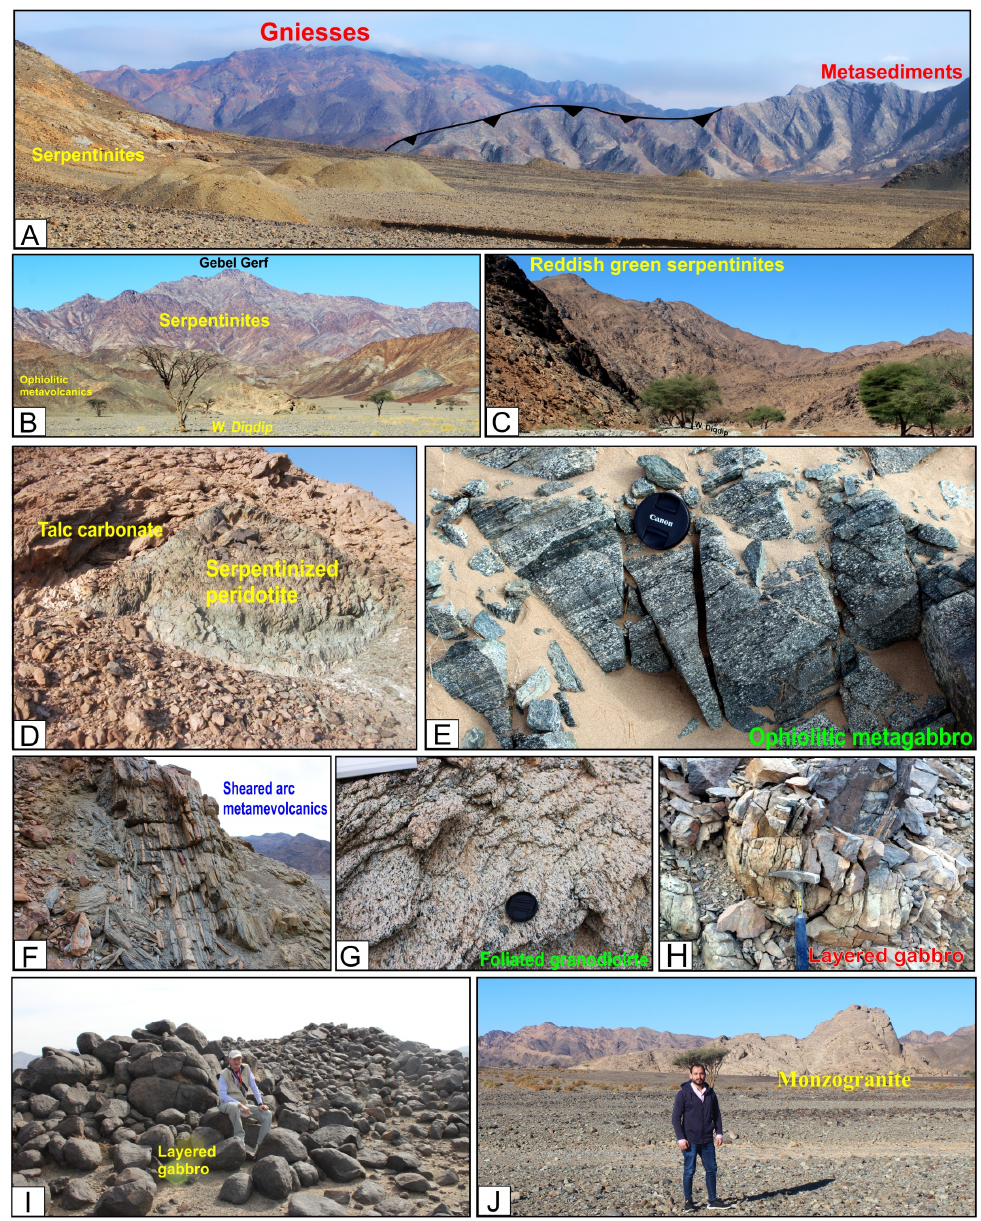
Figure 3. ( A ) A sequence of quartzo-feldspathic gneiss striking N-S juxtaposed with metasediments, ( B ) The greyish green serpentinites of G. Gerf thrust over the ophiolitic metavolcanics ( C ) Reddish green serpentinites along W. Diqdip, ( D ) Small massive masses of the serpentinized peridotite en- closed within the calcite-magnesite rocks of G. Korab Kansi, ( E ) Sheared pod of ophiolitic metagabbro, ( F ) Sheared arc metavolcanics from W. Keriga, ( G ) The foliated granodiorite to the north of G. Korabi, ( H ) The steeply dipping layered gabbro to the south of G. Korab Kansi, ( I ) Layered gabbro to the south of G. Korab Kansi, ( J ) The late-tectonic low relief monzogranites to alkali feldspar granites intrude the serpentinites along W. Sherifa.